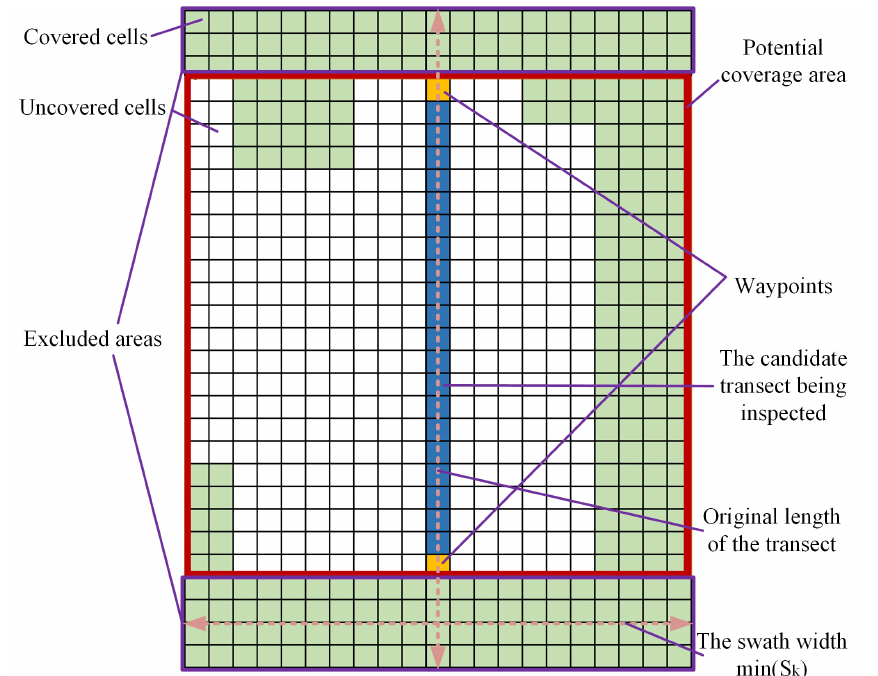
Figure 3. Conception of reducing transect length by examining the current observation and the predicted observation condition in a candidate transect. The transversal width of the predicted coverage is determined to be the minimum swath width observed during the mission, min ( S k ) .